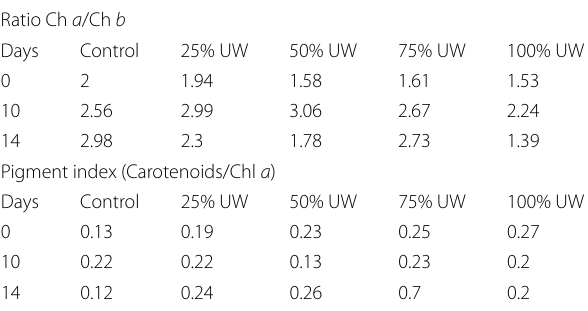
Table 2 Pigments index and chlorophylls a / b ratio evolution along the incubation time (0, 10 and 14 days) in the different